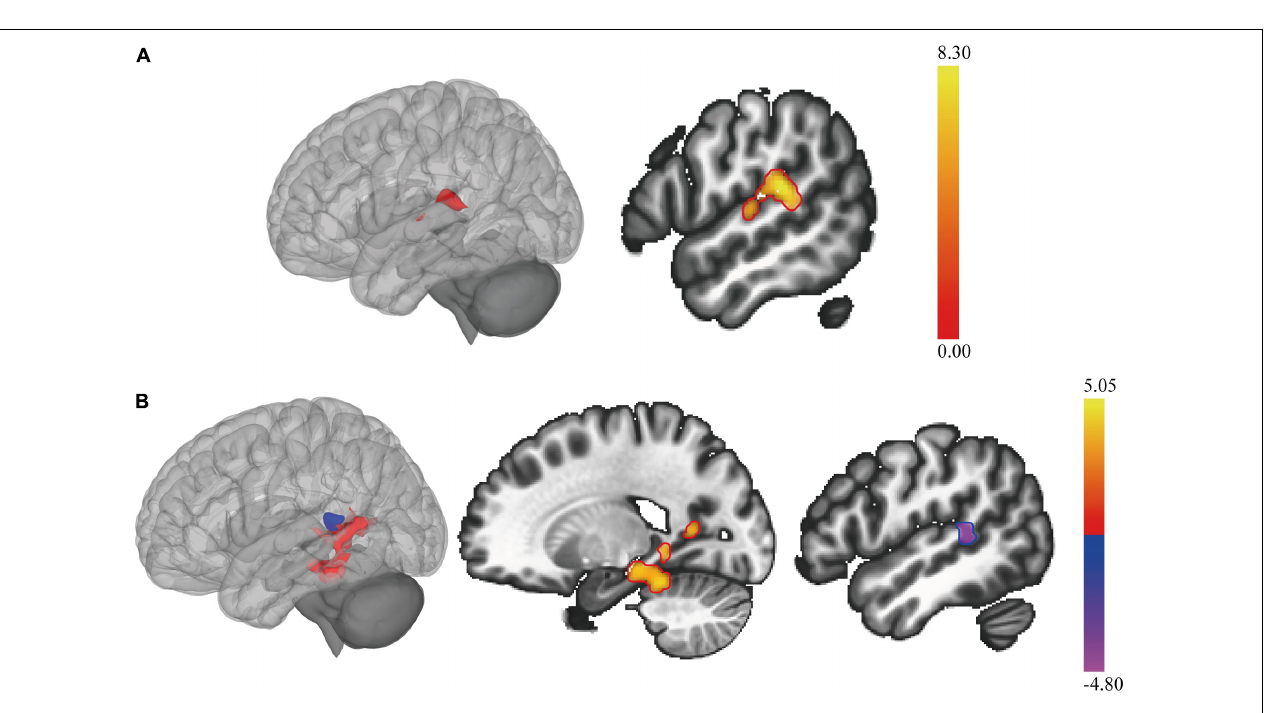
FIGURE 3 | The cerebellar seed-based resting state functional connectivity (RS FC) changes in patients with NPSLE and non-NPSLE. (A) : Clusters of abnormal RS FC between subgroups of patients with SLE, as the bilateral cerebellar posterior lobes (cerebellar Crus I & Crus II) being the seed. (B) : Clusters of abnormal RS FC between subgroups of patients with SLE, as the right cerebellar Crus II being the seed. The colored bar indicates the statistical T distribution between